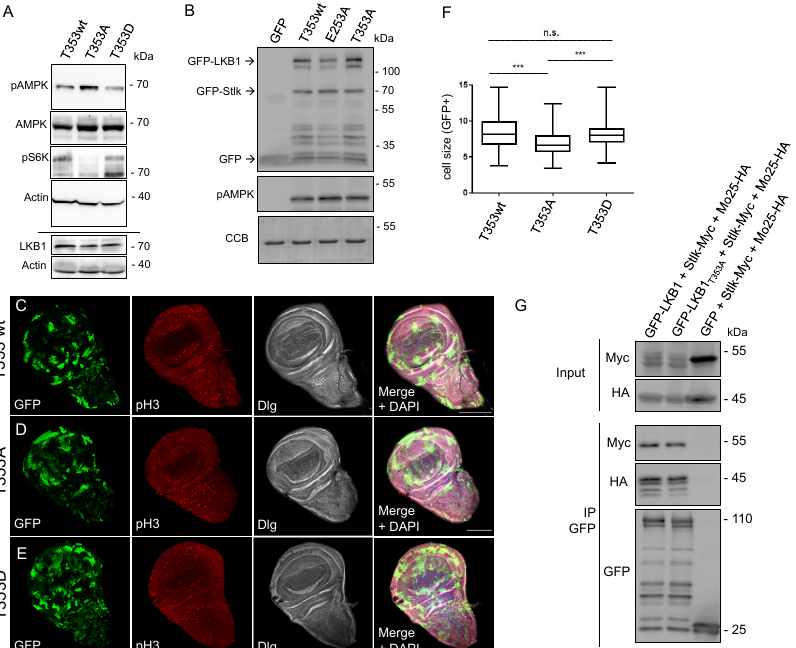
Figure 4. LKB1 T353 phosphorylation regulates AMPK activation, cell size and proliferation in vivo. ( A ) Western blots of embryonic lysates of LKB1 wt, T353A and T353D knockin flies against the indicated proteins. ( B ) In vitro kinase assay with recombinant GST-AMPK (aa 108–280) and